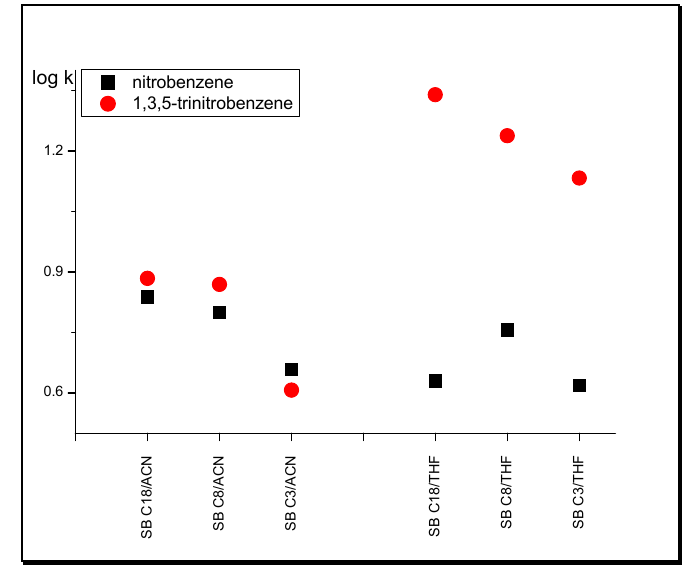
Figure 3. Log k of nitrobenzene and 1,3,5 ‐ trinitrobenzene in systems with different nonpolar stationary phases and tetrahydrofuran (THF) in water and acetonitrile (ACN) in water.